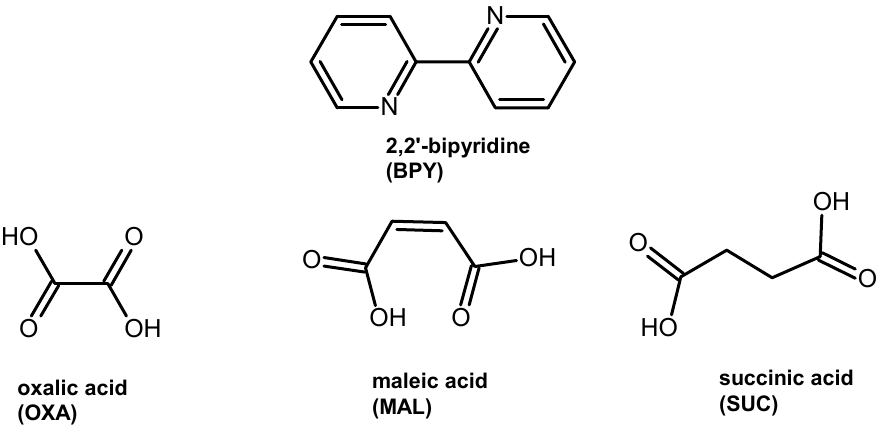
Figure 1. Structures and abbreviations of compounds used in this study.